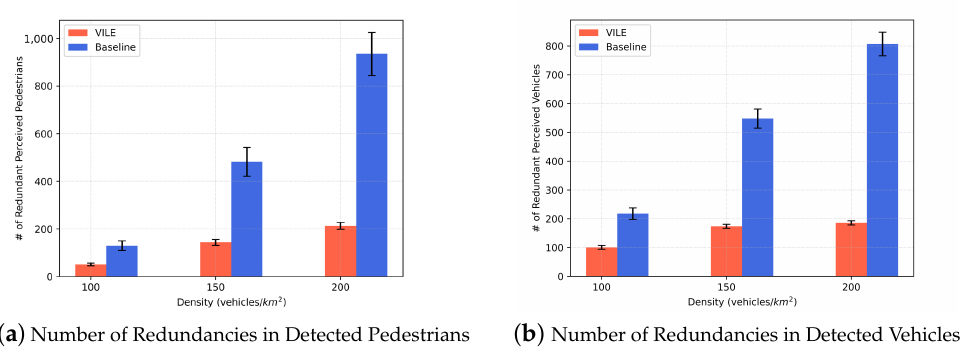
Figure 6. Redundancy results of detected objects (pedestrians and